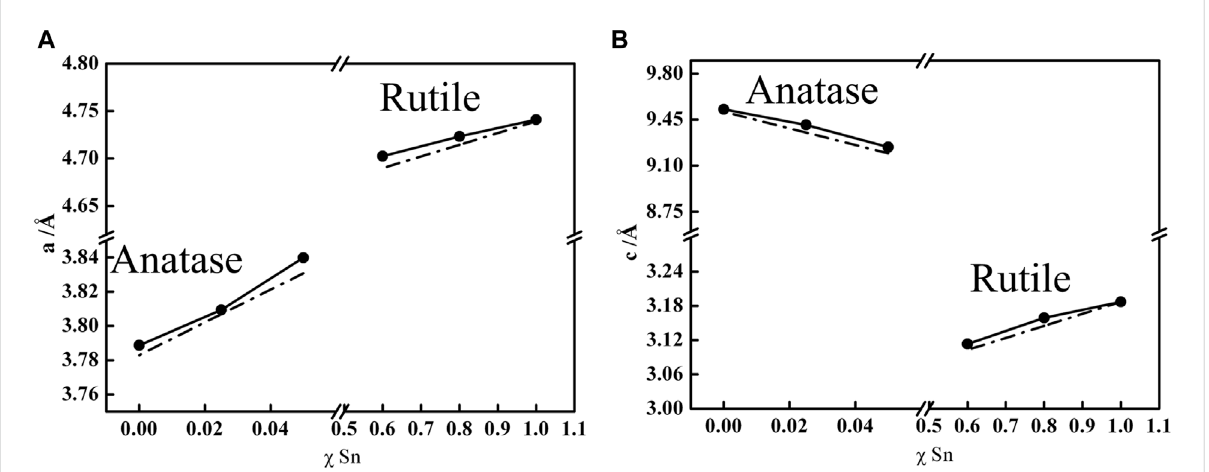
Dependence of the mole fraction of Sn ( χ ) on the a (A) and c (B) lattice parameters of Ti 1-x Sn x O 2 (0 < x < 1) solid solution (solid lines). Dash dot lines represent the theoretical values according to Vegard ’ s law